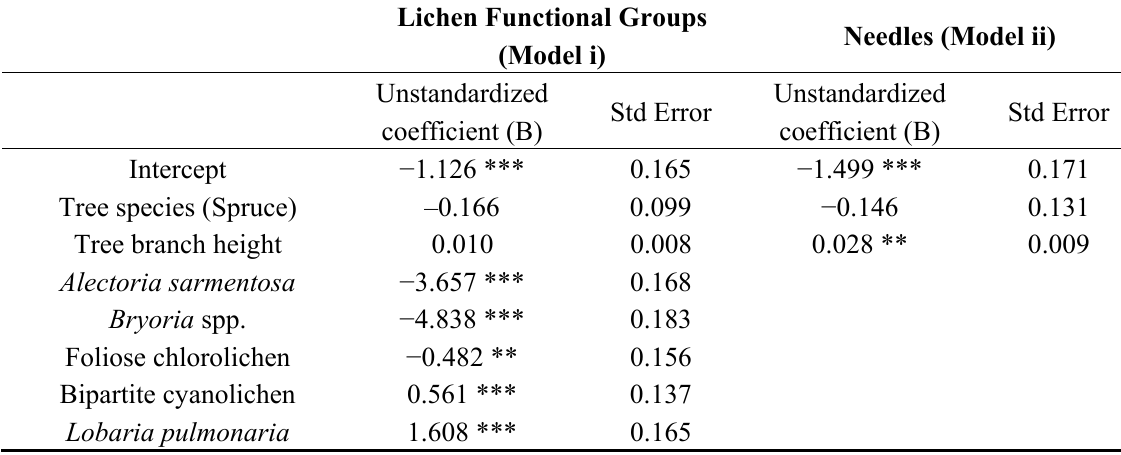
Figure 3. Mean ( a ) δ 15 N and ( b ) %N of host tree foliage (needle) from low to high tree-level cyanolichen abundance (total g tree − 1 ). Table 1. Linear regression (OLS) coefficients with standard error for the regression model predicting δ 15 N of lichen functional groups (F = 220.501, p < 0.001, R 2 = 0.817) and host tree needles (F = 4.363, p = 0.006, R 2 = 0.126) based on tree species (spruce and fir), cyanolichen abundance, tree branch height, and lichen species or functional